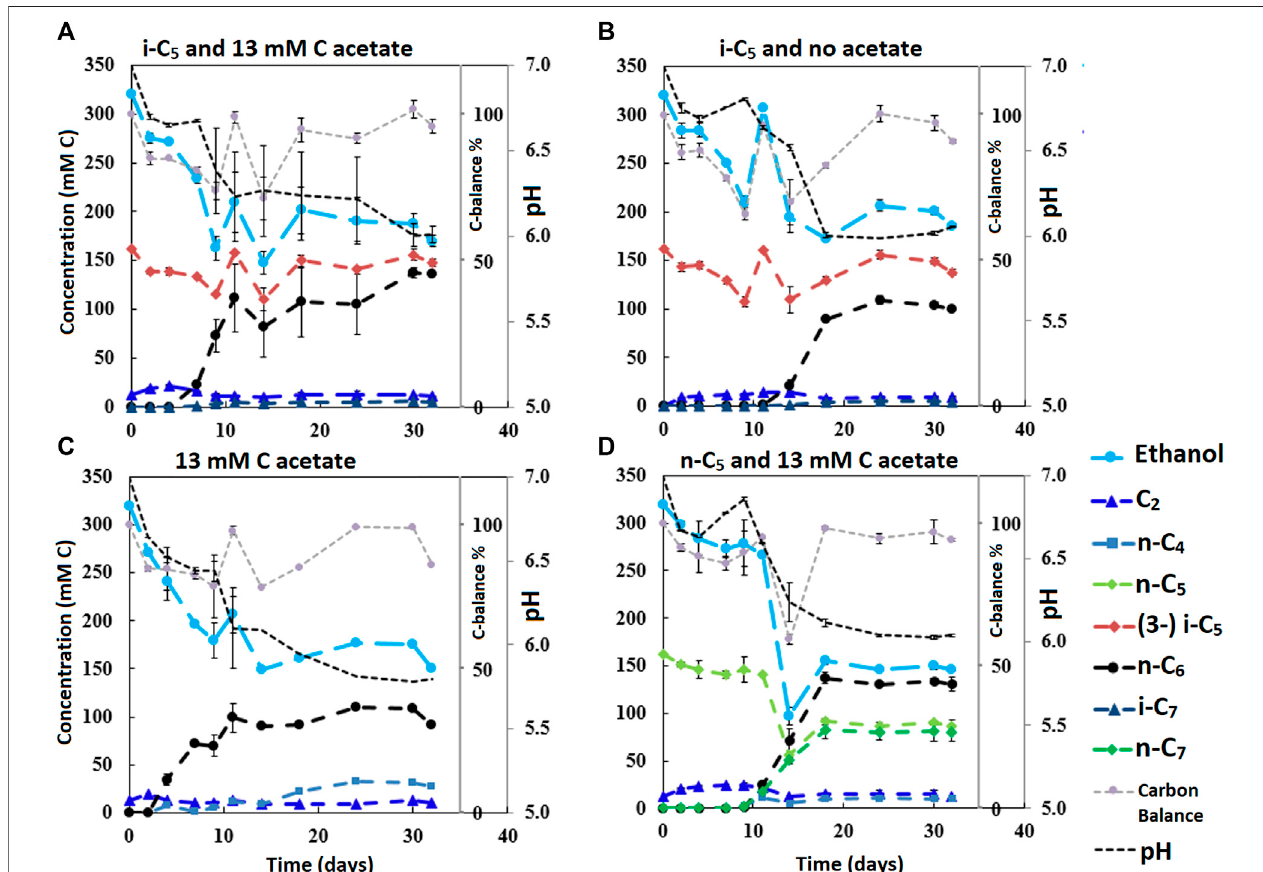
FIGURE 3 | The four batches illustrate the effect of different initial acetate amounts and added carboxylates beside acetate on chain elongation activity. Complete absence of initial acetate (B) causes a prolonged lag phase, whereas the addition of a small amount (A) sped up the onset of chain elongation by approximately 7 days. Additionally, the batch without any additional carboxylate besides acetate shows an even faster onset of chain elongation activity (C) . The batch with added n-C 5 (D) shows